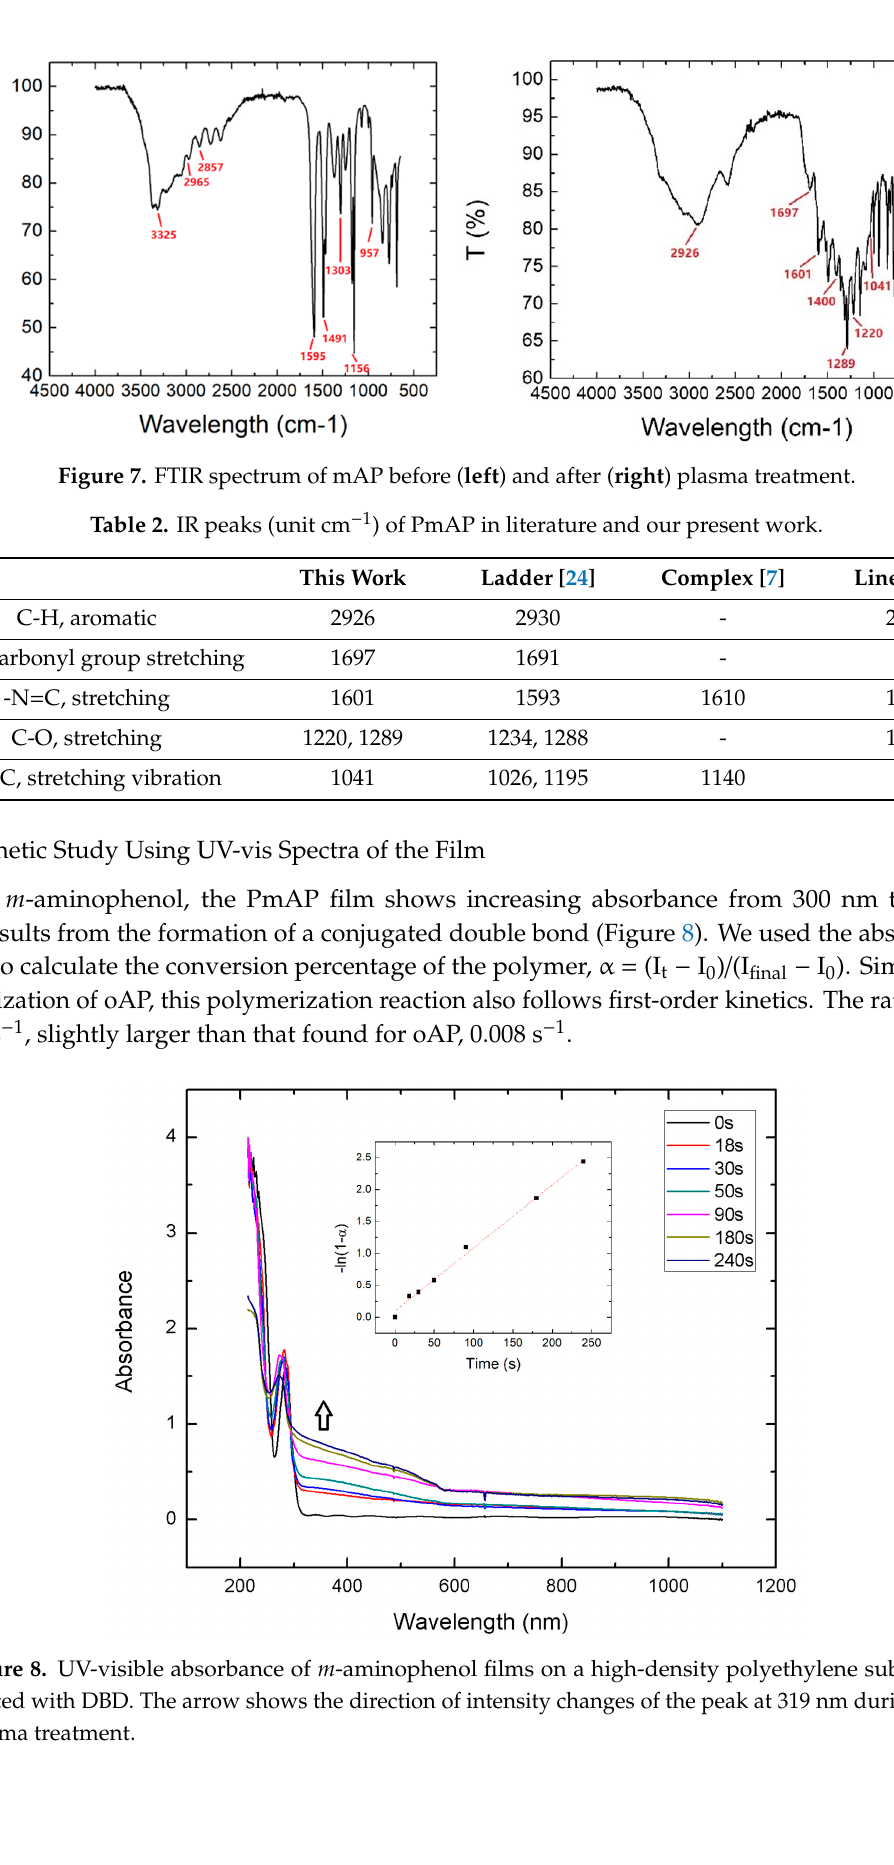
Figure 9. Conductivity of m -aminophenol film after plasma treatment.